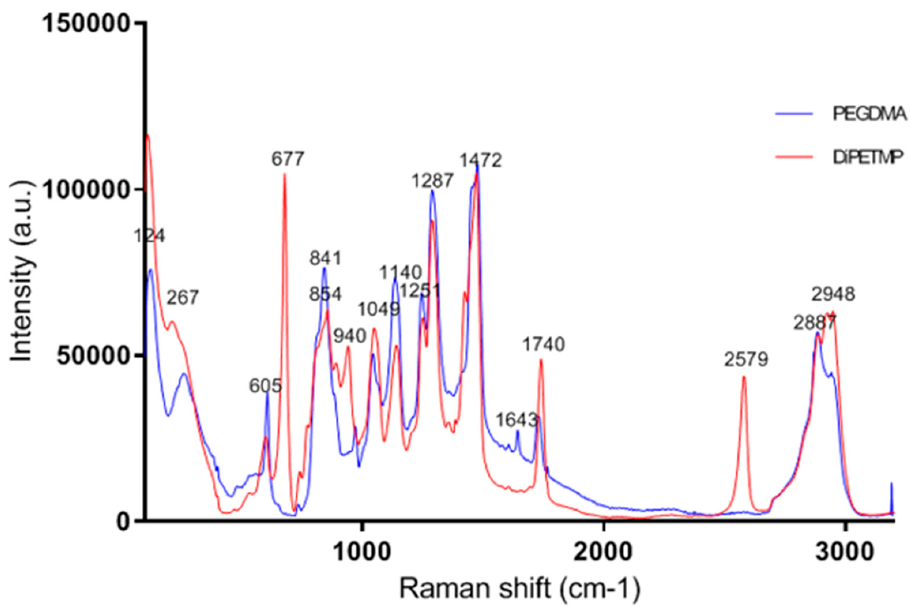
Figure 11. The Raman spectra for the PEGDMA and PEGDMA-DiPETMP samples.